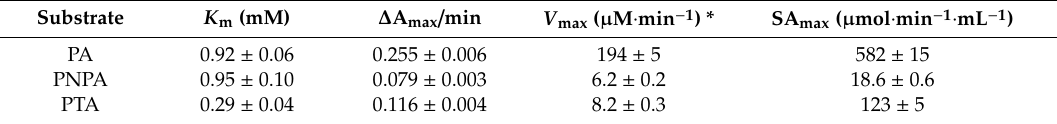
Figure 2. The rates of hydrolysis of phenyl acetate (PA), p -nitrophenyl acetate (PNPA) and of S -phenyl thioacetate (PTA) by rePON1. Points represent average values of three independent experiments corrected for the spontaneous hydrolysis of the corresponding substrate. Solid lines are curves calculated by the Michaelis–Menten equation and the parameters given in Table 1. Table 1. Catalytic constants K m and V max . The rates of rePON1 hydrolysis of phenyl acetate (PA), p -nitrophenyl acetate (PNPA) and S -phenyl thioacetate (PTA) were determined from at least three experiments, and in each case all of the activities were measured in duplicates.